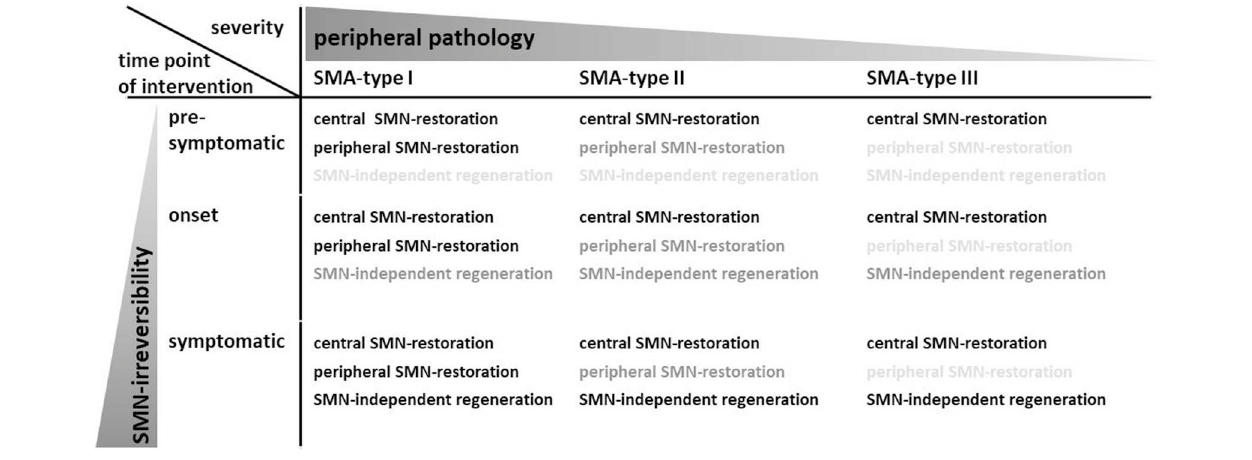
TABLE 1 | Severity and time point of intervention critically determines the treatment